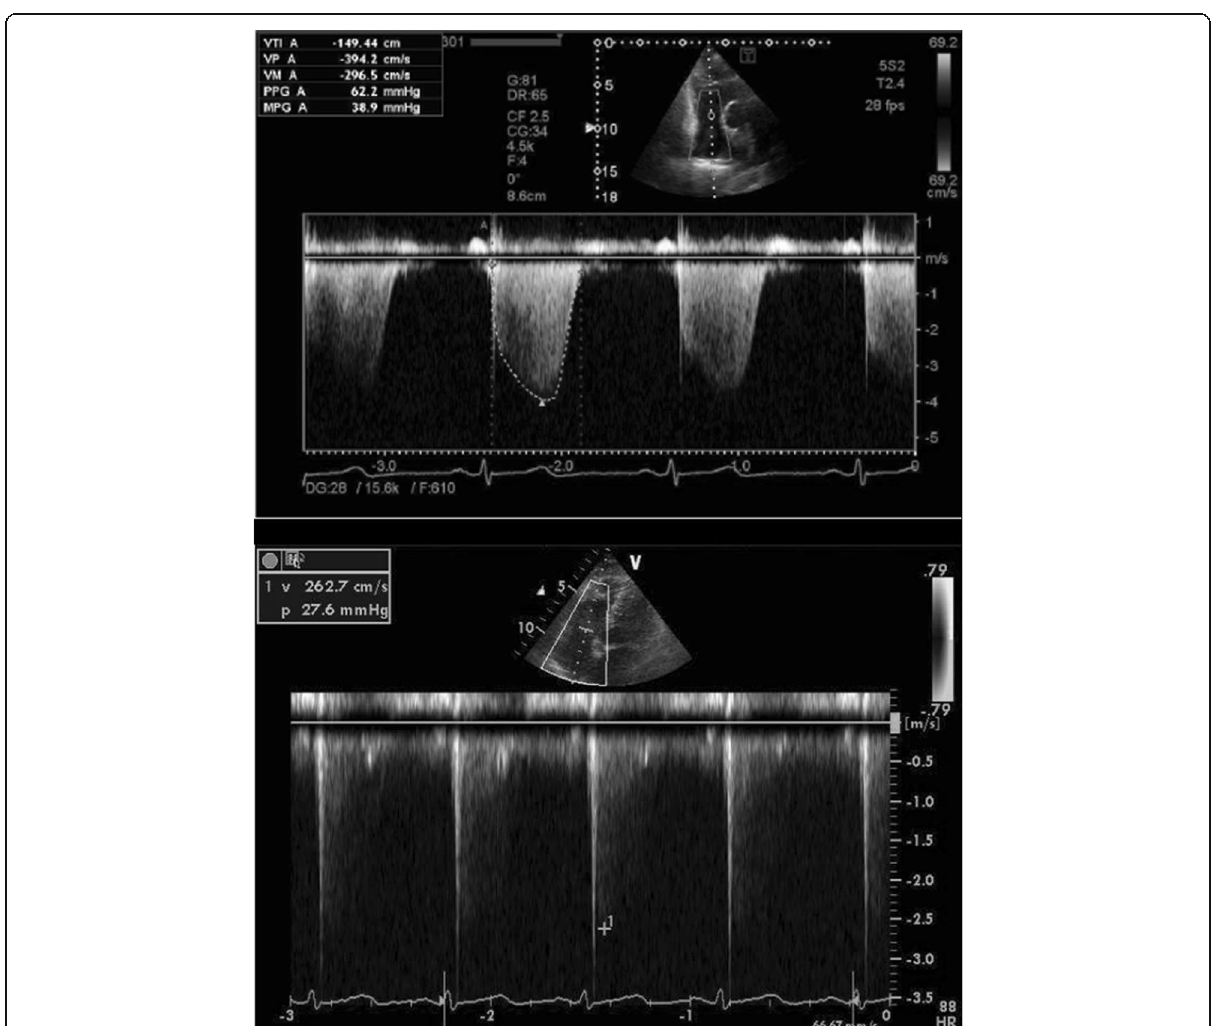
Fig. 2 Two-dimensional Doppler echocardiographic images of tricuspid regurgitation 1 month before LDLT (upper) and 2 months after LDLT